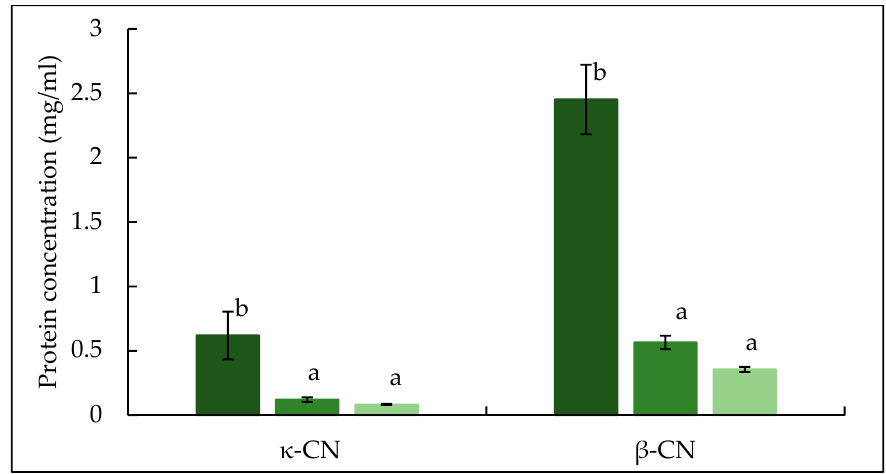
Figure 9. Concentration of κ - casein and β - casein in permeate samples produced during microfiltration of mTG crosslinked micellar casein concentrate feed at 5 ± 0.5 °C. CTR: no enzyme treatment ( ■) ; TA: 5 °C/24 h ( ■) ; TB: 40 °C/90 min ( ■). Different lowercase letters indicate significant differences ( p < 0.05) between proteins.